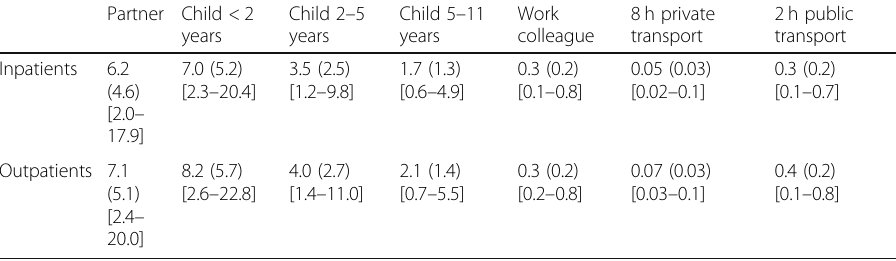
Table 4 Mean (SD) [range] equivalent dose (mSv) per cycle to close relatives and members of the public for inpatient and outpatient 177 Lu-DOTATATE administrations resulting from no restriction on contact with